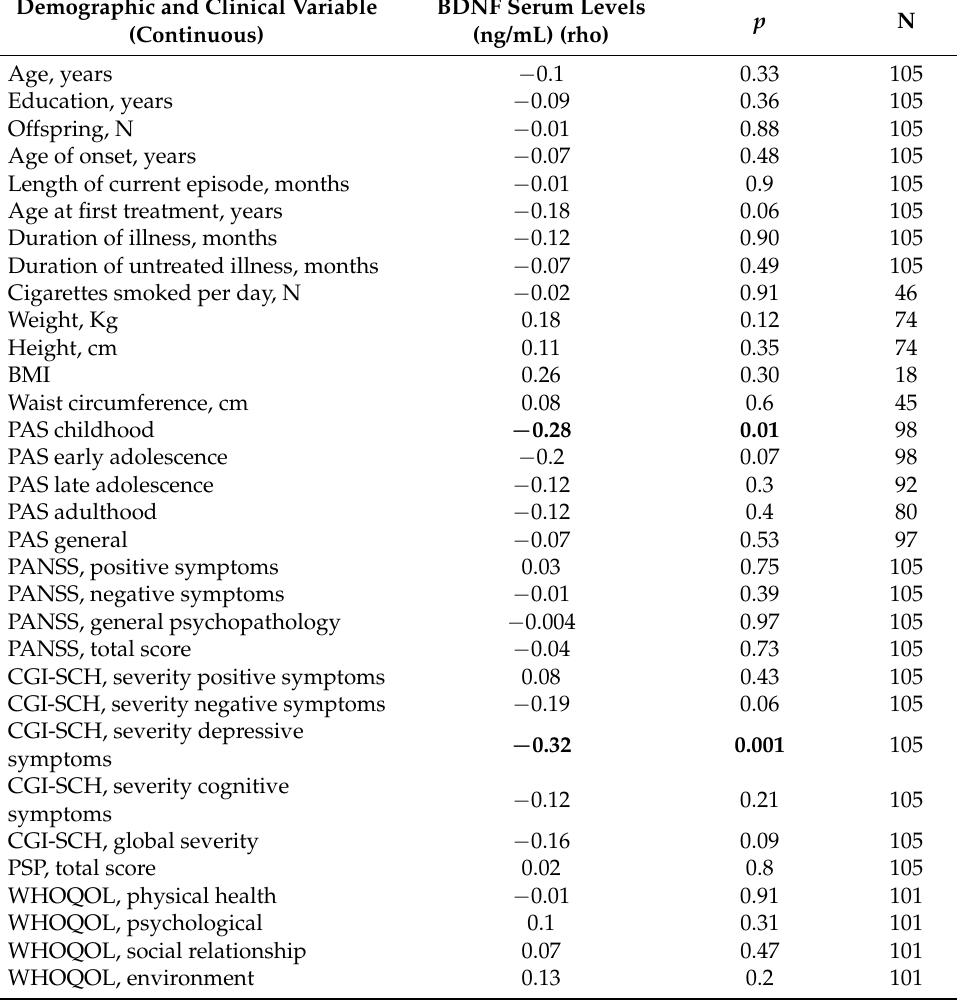
Table 3. Association of BDNF serum levels with continuous demographic and clinical variables in 105 patients with schizophrenia and schizoaffective disorder. Demographic and Clinical